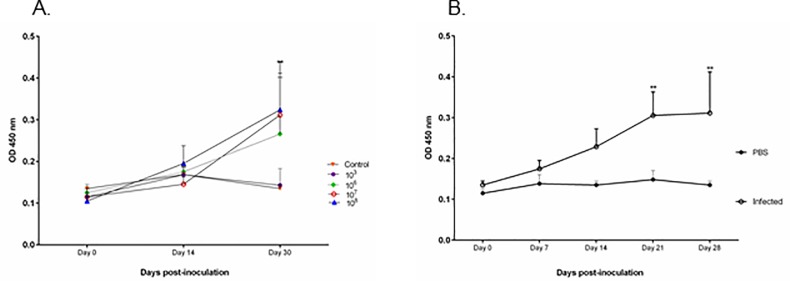
Humoral response to Brucella infection in guinea pigs.(A) Anti-Brucella specific IgG ELISA with sera from guinea pigs inoculated by intratracheal route with B. melitensis 16M at doses of 103, 106, 107, 108, or uninfected control at day 0, 14, and 30 post-inoculation. (B) The kinetics of the IgG response was evaluated at 1,2,3, and 4-weeks post-infection in guinea pigs (n = 4) inoculated with 1x107 CFU. Guinea pigs in the 107 and 108 groups developed a statistically significant humoral response to inoculation with B. melitensis. The results are expressed as the mean absorbance (± standard error). Statistical significance was determined by ANOVA followed by Dunnett’s multiple-comparison of each group (n = 4) to the uninfected controls (n = 3). Two asterisks, P < 0.01.